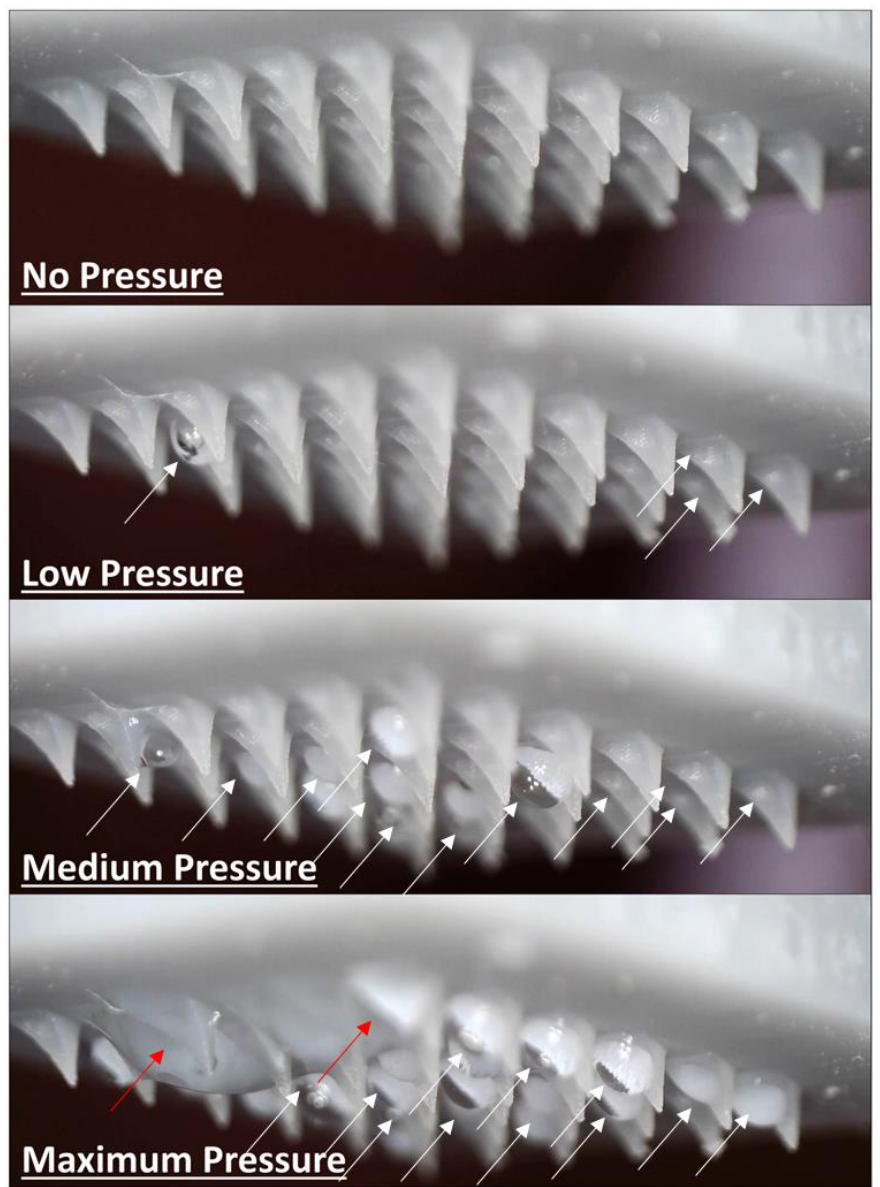
Figure 15. Flow testing of the device at different flow rates. White arrows indicate the distinct liquid droplets formed at individual microneedles, and red arrows indicate coalesced droplets from multiple microneedles that form a continuous superficial liquid film.